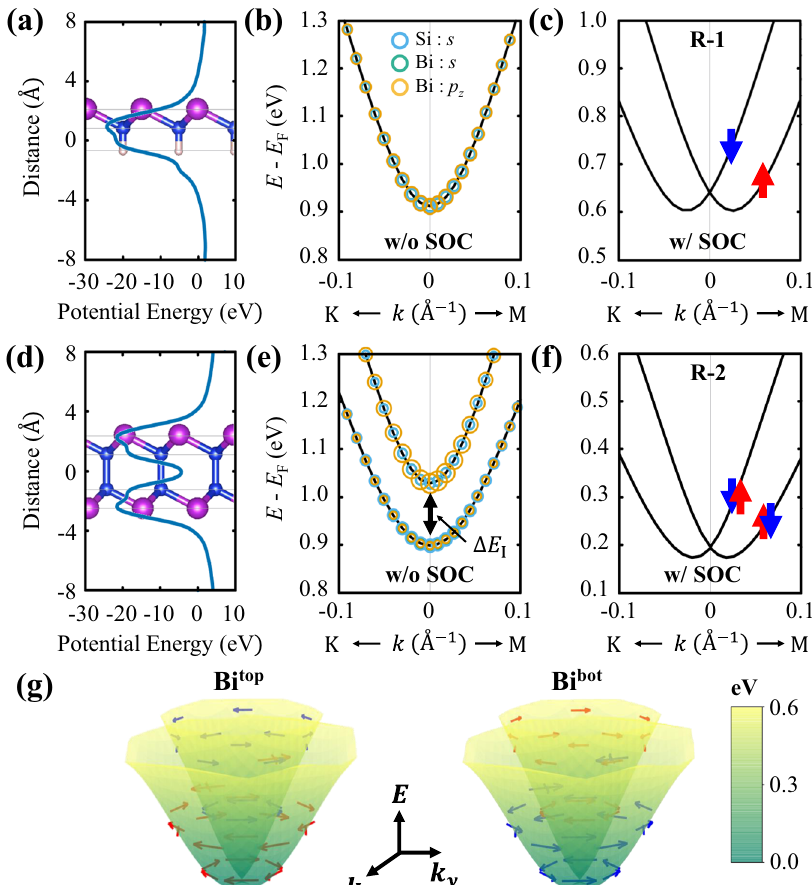
Fig. 2 Hidden Rashba spin-layer locking in I -Si 2 Bi 2 . Plane-averaged electrostatic potentials and electronic structures near the conduction band minima of an arti fi cially constructed asymmetric 2D SiBi monolayer ( a – c ) and I -Si 2 Bi 2 ( d – f ). The respective structures, in which Si and Bi atoms are depicted by the purple and blue spheres, respectively, are overlaid in ( a ) and ( d ). The dangling bond of each Si atom in ( a ) is saturated with a hydrogen atom depicted with the white sphere. The electronic band structures are shown without SOC in ( b ) and ( e ), and with SOC in ( c ) and ( f ). The latter two cases clearly show the Rashba band splittings, one with the R-1 and the other with the R-2. Local orbital contributions are displayed with skyblue, green, and yellow circles for Si s , Bi s , and p z orbitals, respectively. The radius of circle indicates the degree of the orbital contribution. The Δ E I in ( e ) indicates the splitting energy between CB1 and CB2 due to the interaction between the top and bottom SLs. The red and blue arrows denote spin states in ( c ) and ( f ). ( g ) Spin textures spatially resolved on the top (left) and bottom (right) Bi SLs, or Bi top and Bi bot , plotted on the Rashba bands shown in ( f ). Red (blue) arrows represent the clockwise (counterclockwise) spin chirality and the colorbox indicates energy scale in eV relative to the bottom of the conduction